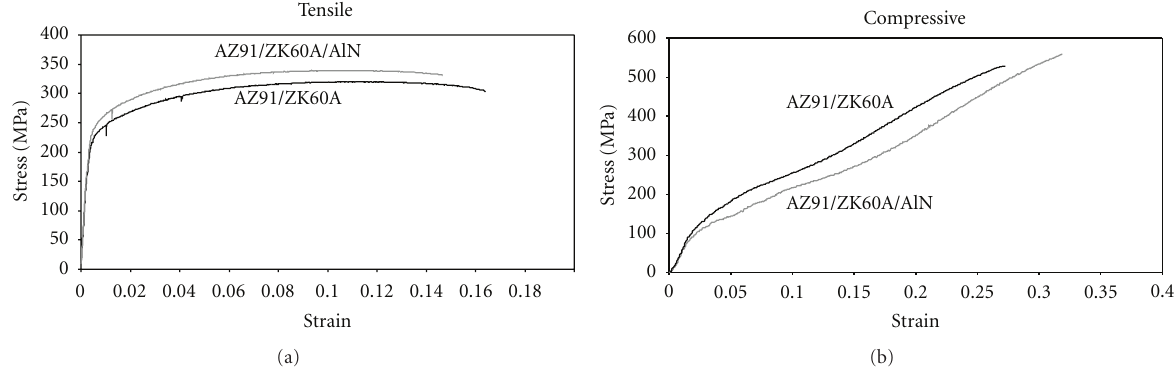
Figure 4: Representative: (a) tensile and (b) compressive stress-strain curves of monolithic AZ91/ZK60A and AZ91/ZK60A/AlN nano- composite.